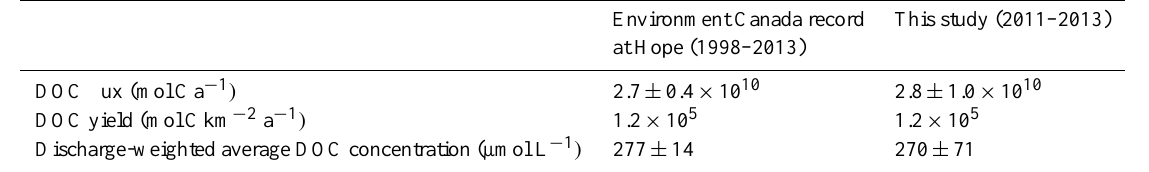
Table 3. Discharge-weighted fluxes and concentrations of DOC in the Fraser River. Environment Canada data were accessed online at http://aquatic.pyr.ec.gc.ca. Sampling for both Environment Canada and this study was performed at approximately twice monthly frequency, with the exception of our 2013 freshet sampling, for which sampling was